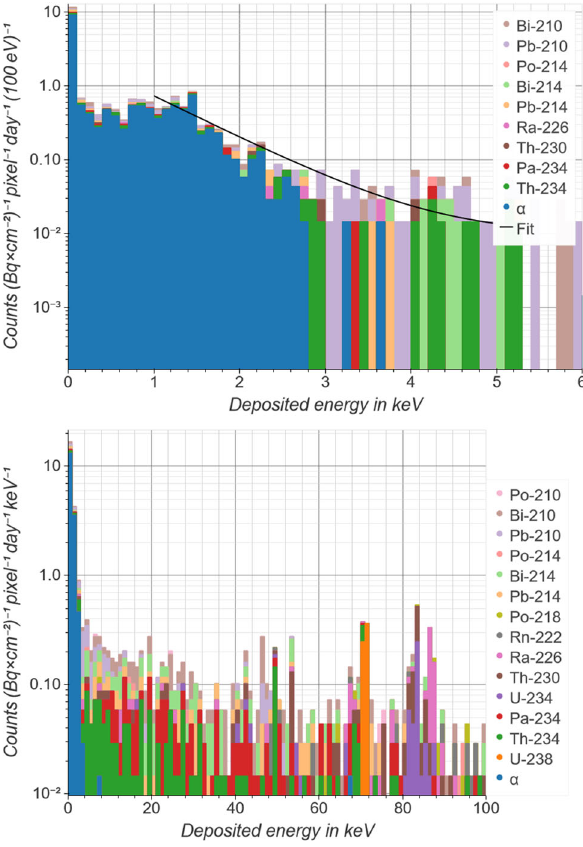
Fig. 10 Simulated spectrum of deposited energies in the MMC absorbers caused by the surface-distributed 238 U on the aluminum shielding. Lines caused by the α -decaying isotopes can be identified.